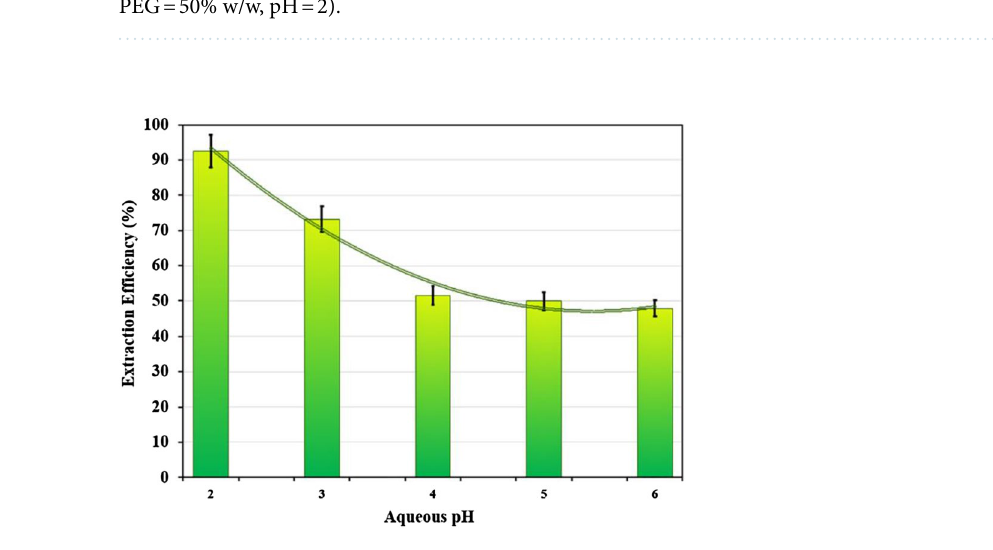
Figure 7. Effect of pH on the extraction of Co(II) (T = 25 °C, Time = 30 min, Co(II) = 500 ppm, PEG = 50% w/w, (NH 4 ) 2 SO 4 = 4